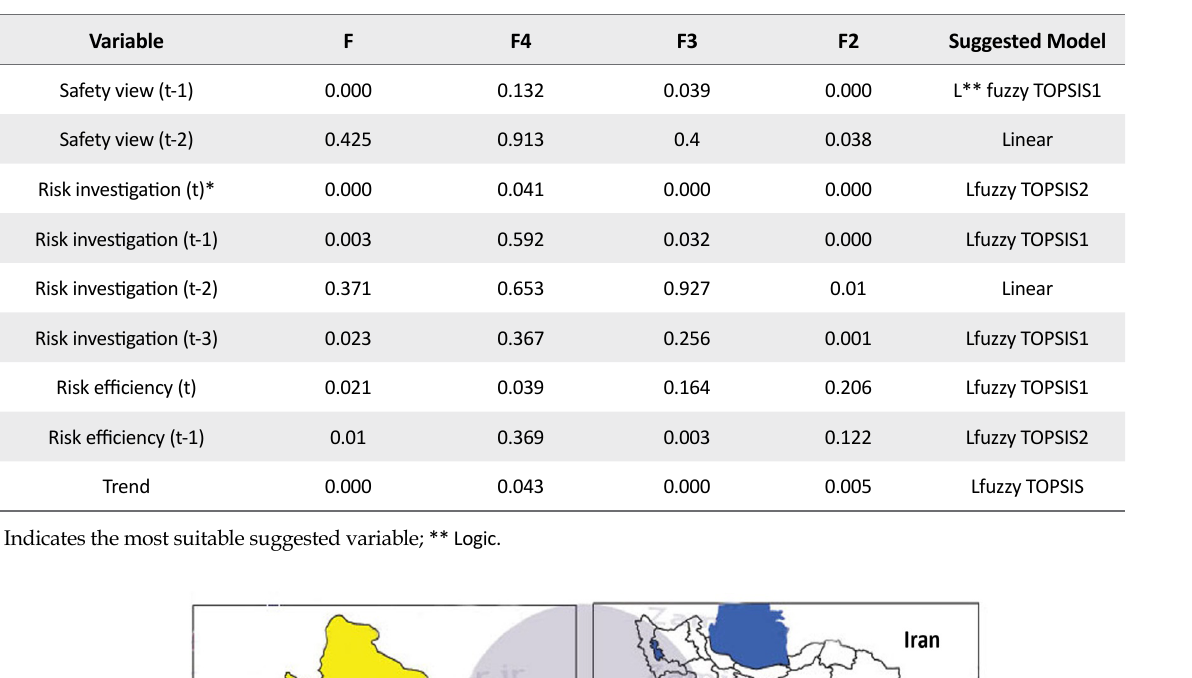
Table 6. Selecting The Model and the Variables With Respect to the F Values